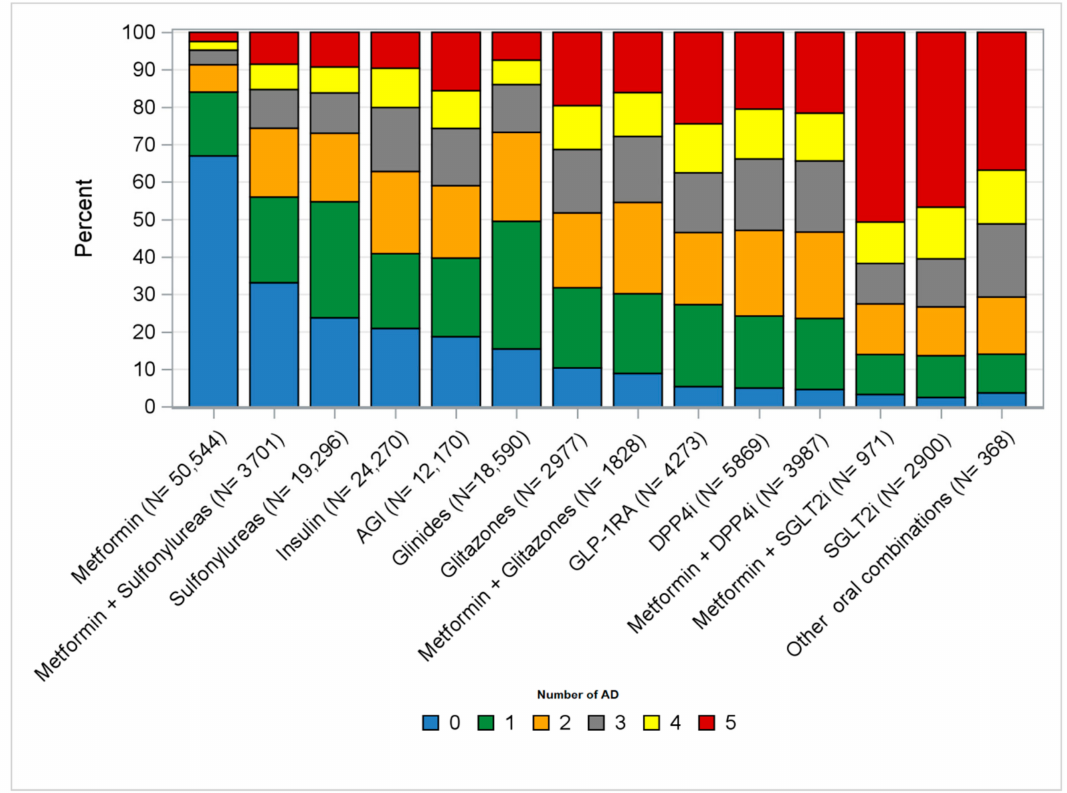
Figure 3. Distribution (%) of the number of ADs dispensed any time prior to the treatment start among incident treatments. Legend: AGI = alpha-glucosidase inhibitors; DPP4i = dipeptidyl peptidase-4 inhibitors; GLP-1RA = glucagon-like peptide-1 receptor antagonists; SGLT2i = sodium–glucose